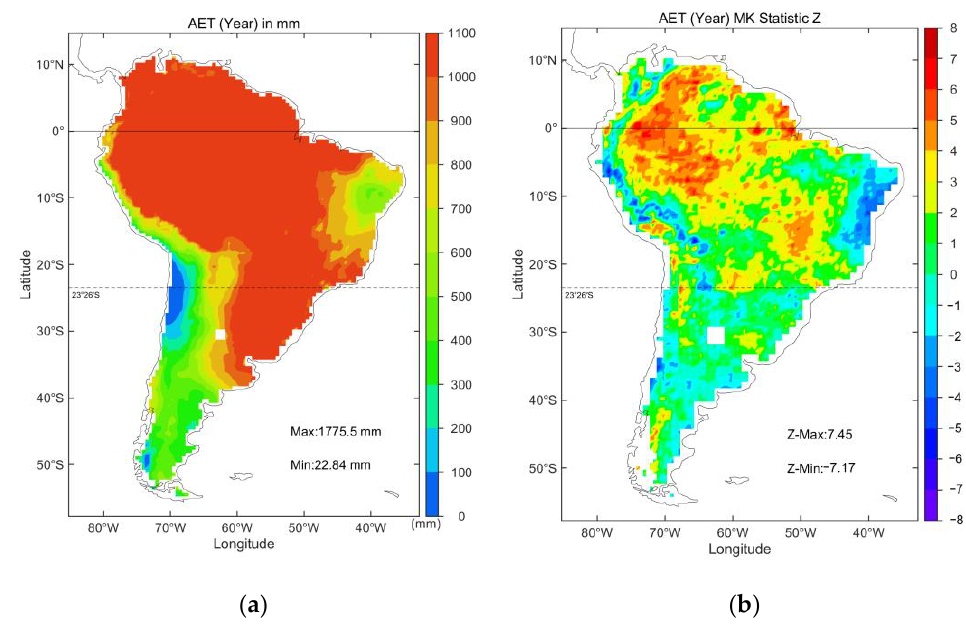
Figure 4. Spatial distribution of multi-year average AET ( a ) and MK statistic Z ( b ).